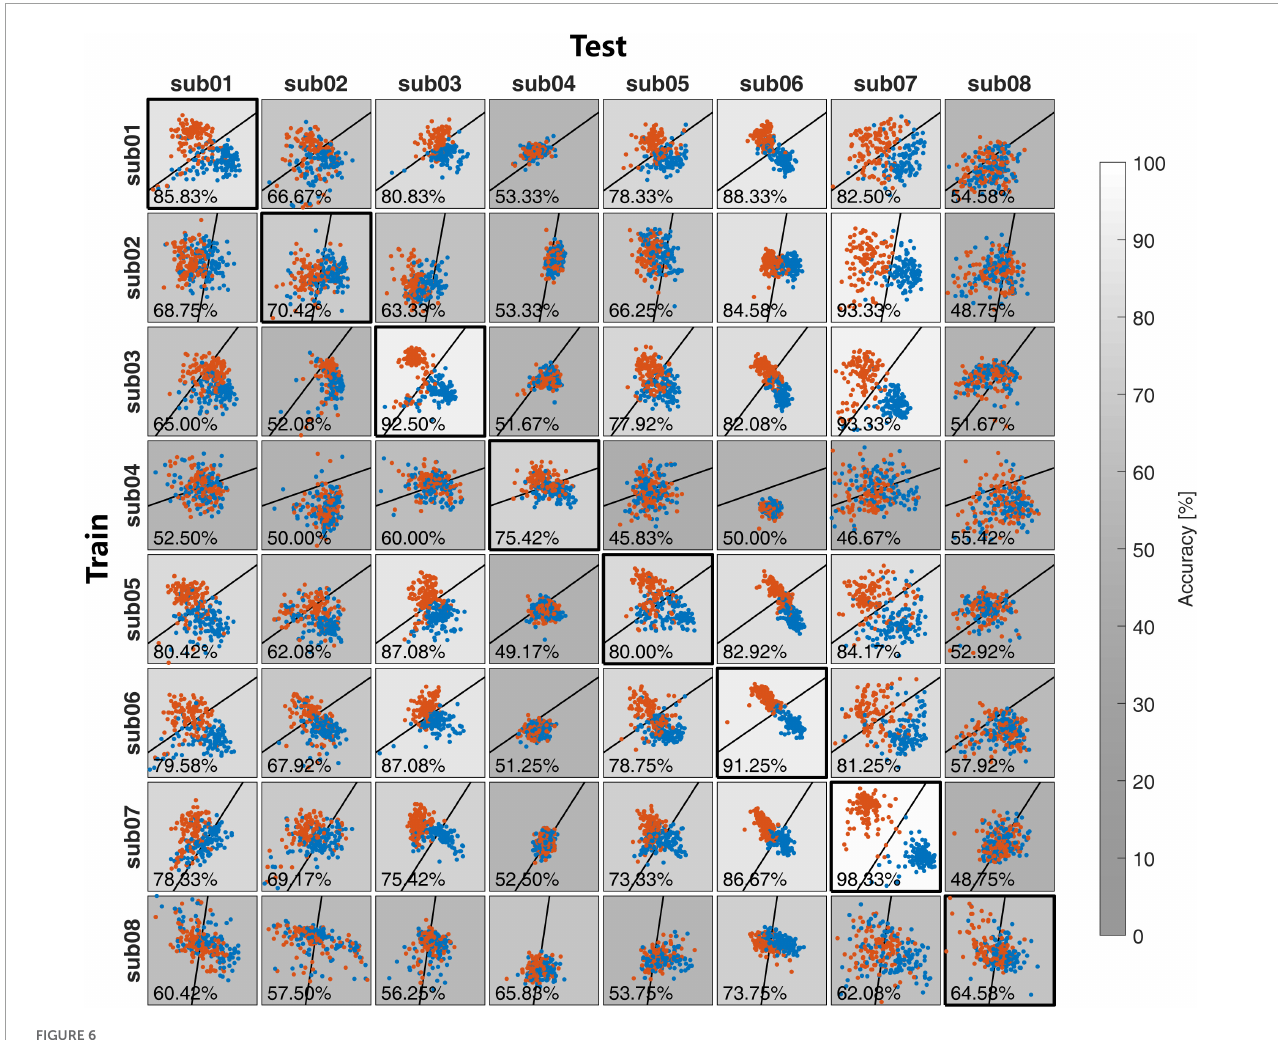
FIGURE6 The feature distribution and the classification accuracies in the cross-subject in Exp1.